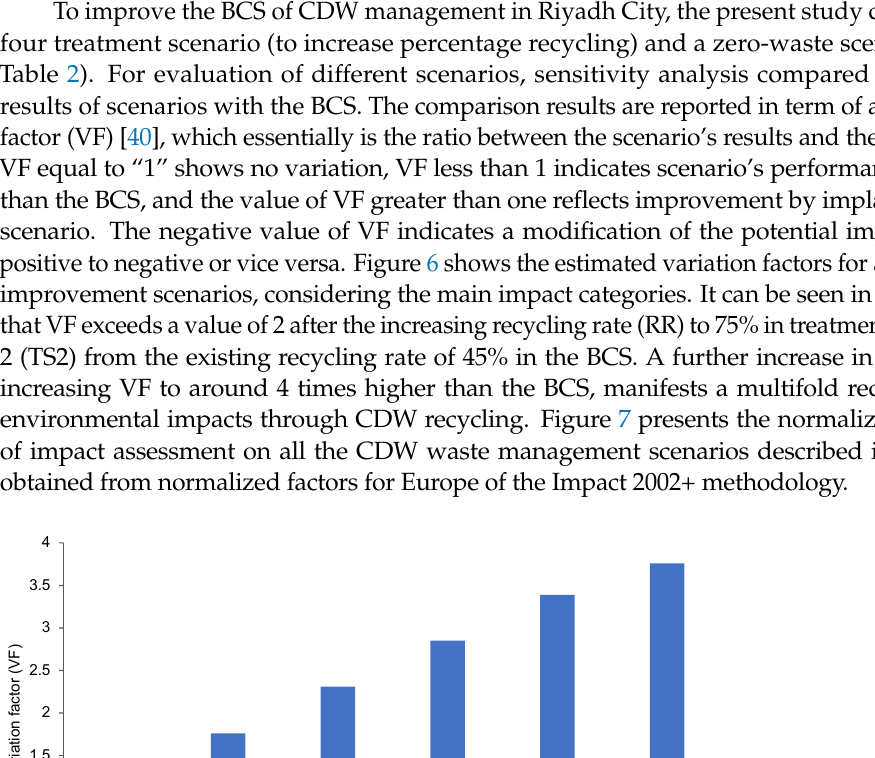
Figure 7. Normalized results of impact assessment obtained by using normalized factors for Europe of Impact 2002+ methodology. ( a ) normalized midpoint results comparing the BCS (BCS with 45% recycling rate in 2021) with TS1 Treatment Scenario 1 (TS1 with 61% recycling rate in 2022), TS2 with